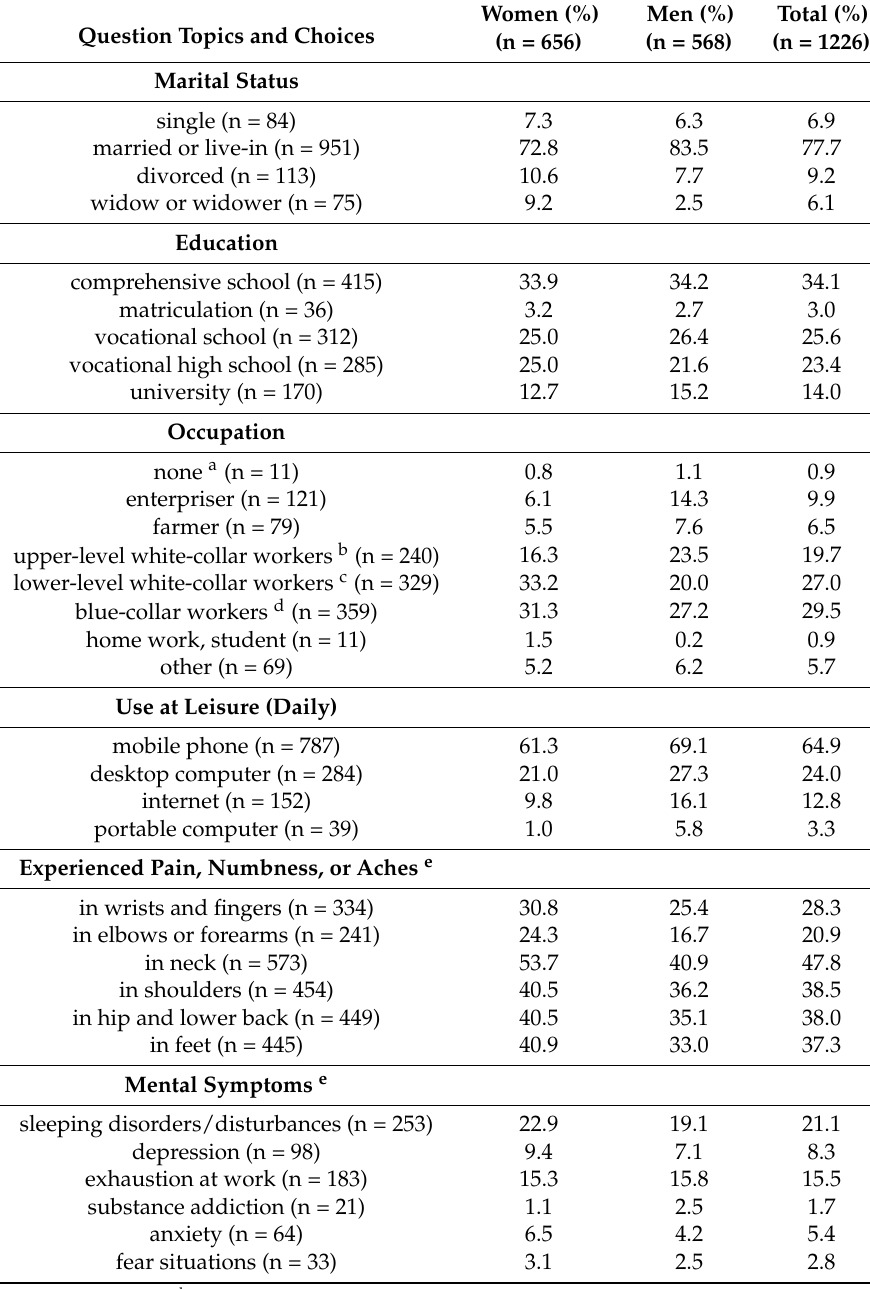
Table 1. Summary of background information and the results of all ≥ 55-year-old participants. The daily use of different devices/computers at leisure, physical and mental symptoms, (number of positive answers including answers “quite often”, “often”, and “very